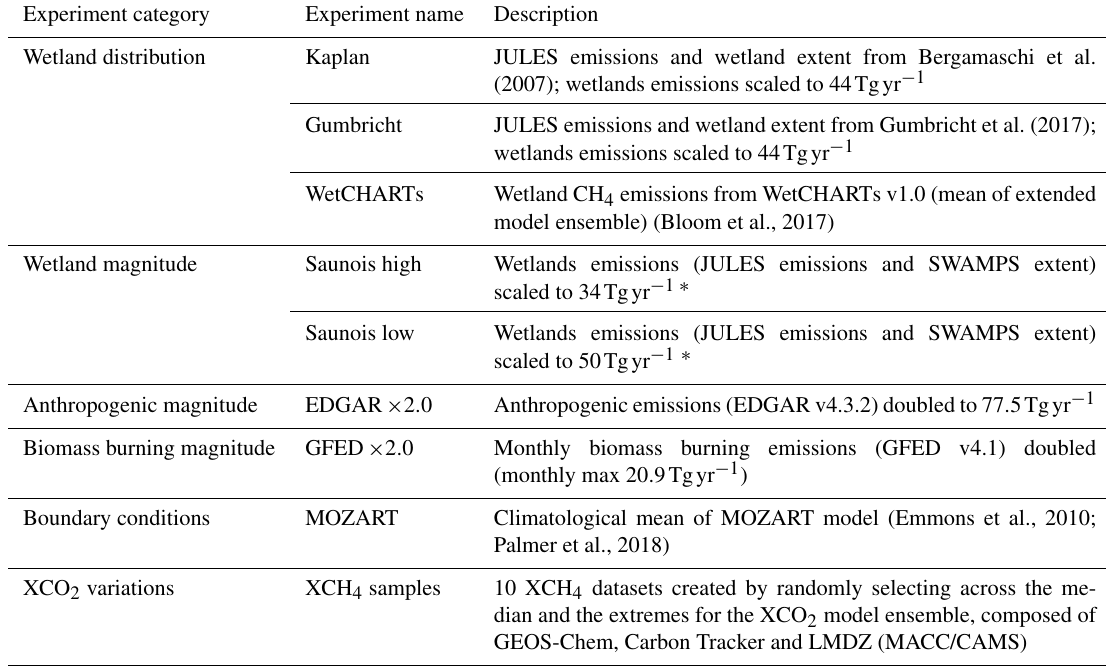
Table 2. Sensitivity studies performed in this study for a priori fields or for model XCO 2 . For the a priori emissions, each sector was varied one at a time over the full South America domain with other sectors kept in their original